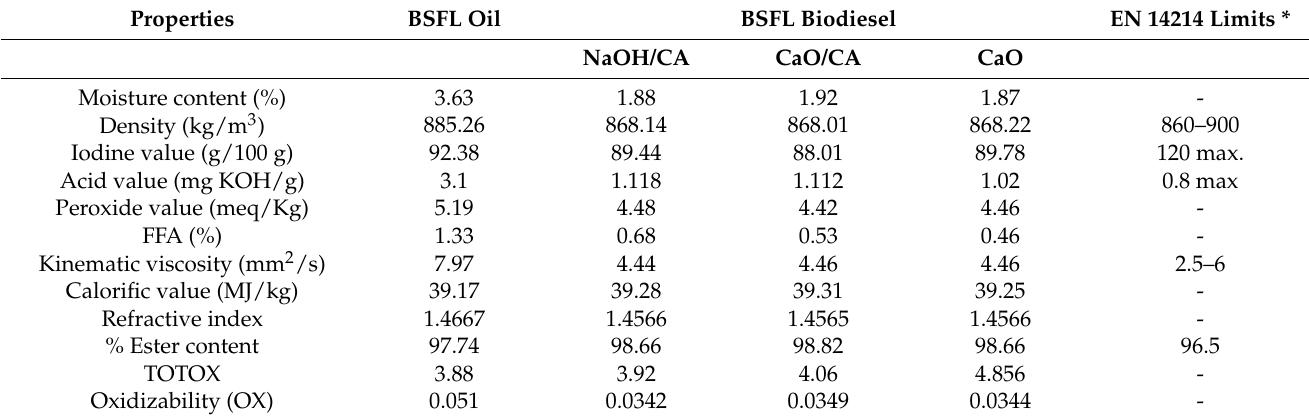
Table 2. Physiochemical properties of BSFL oil and biodiesel.